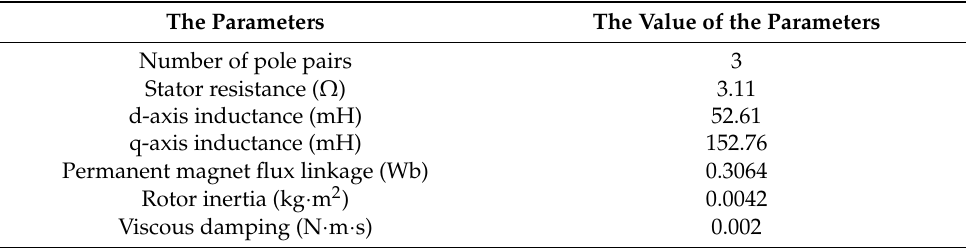
Table 2. The parameters of the